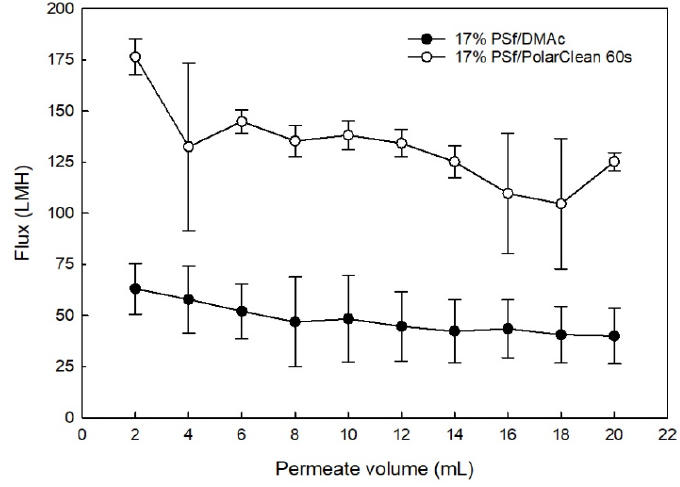
Figure 8. BSA solution permeability (at 4 bar).